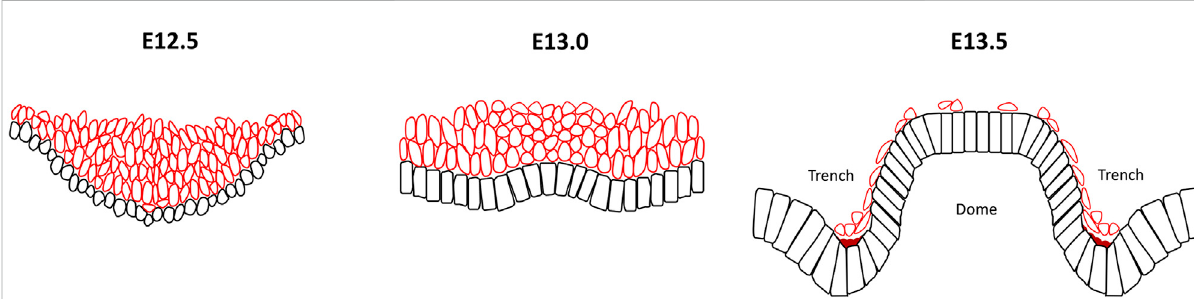
FIGURE 4 Reverse curve morphogenesis in the circumvallate papillae of the tongue. At E12.5 the developing circumvallate papillae consists of an invaginatedplacodewithroundepithelialbasalcells, elongatedsuprabasalcellsandactomyosinenrichmentatthebasal surfaceofthebasalcells.At E13.0, inwards folding changes to outwards bend in the centre of the placode with a low cell density mesenchyme localized under the evagination. The wedged-shape basal cells in the medial region exhibit basal constriction with actomyosin accumulation whilst the overlying suprabasal cells become more ovoid shape and cells in the lateral part maintain a columnar morphology. At E13.5, the strati fi ed epithelium gives rise to two bilateral trenches with a central dome that exhibit basal constriction of the basal epithelial cells present at the lateral side of the trench and medial regionofthedome.Incontrast,thebasalepithelialcellsinthemediantrenchregionshowapicalconstriction.Additionally,anotablereductioninthe number of suprabasal cells is seen. Black cells, basal cells; red cells, suprabasal cells; dark red region, actomyosin